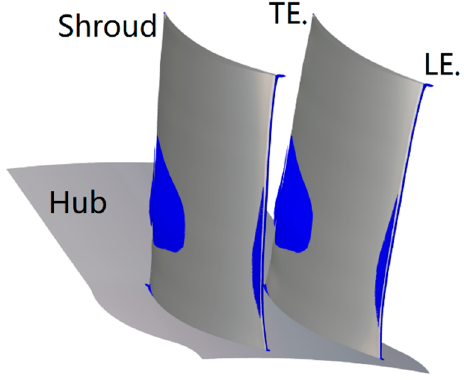
Figure 10. Iso ‐ surface of the axial velocity ( − 1 m/s) for stator 5 of the baseline (near the stall points). TE.: trailing edge; LE.: leading